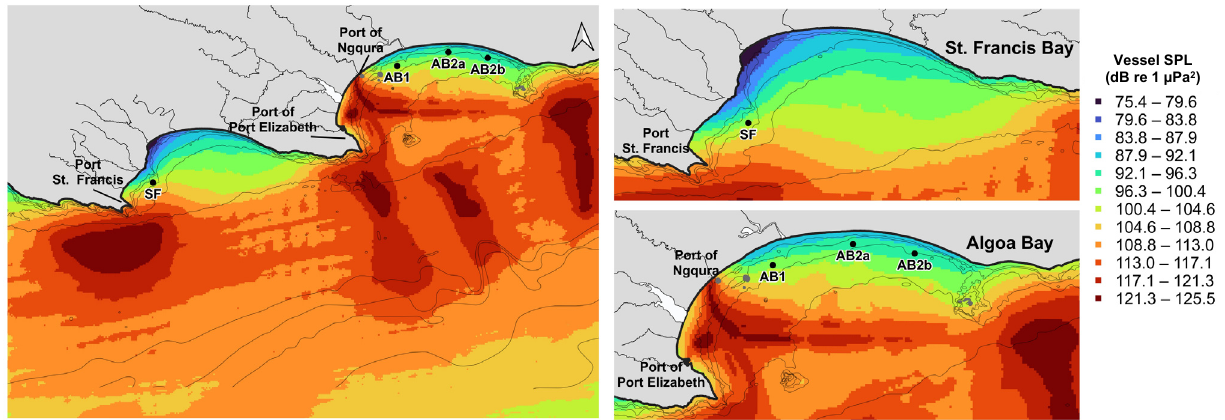
Figure 9. Modelled average received mean-square sound pressure level (SPL) from all vessel classes combined, in St. Francis Bay and Algoa Bay, Eastern Cape, South Africa. Levels represent the maximum over the top 100 m from vessels traversing up to 80 km from Cape St. Francis (i.e., headland south of Port St.